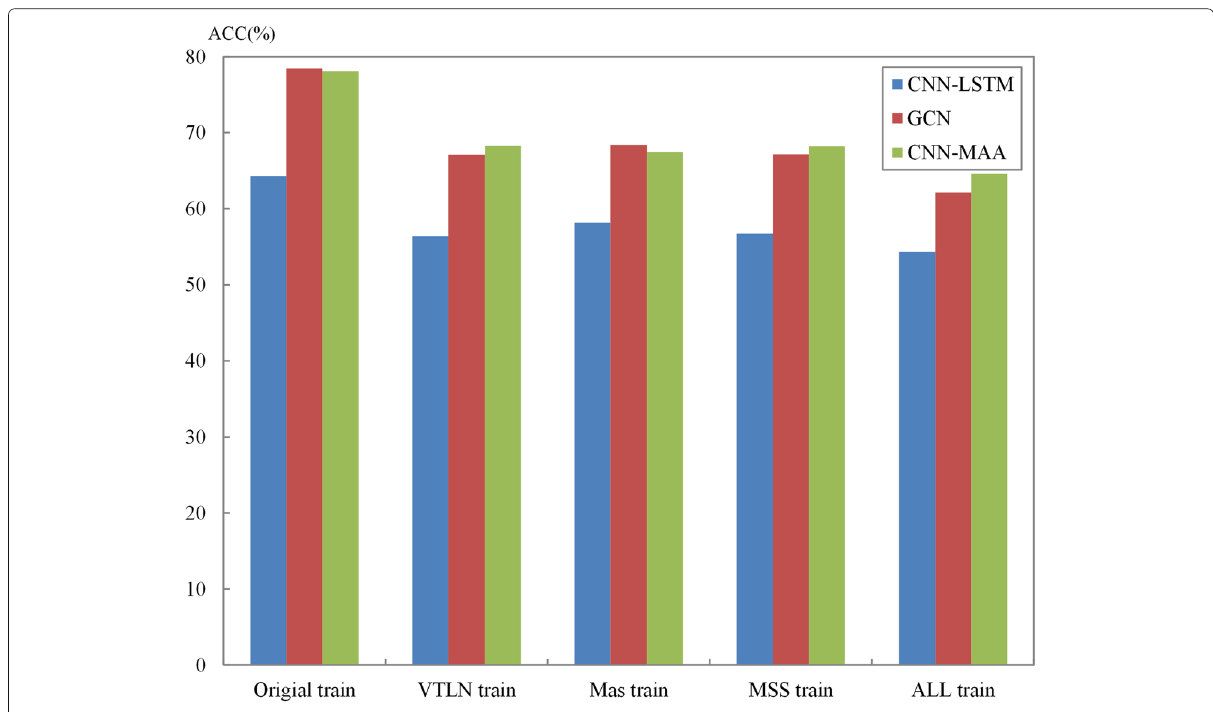
Fig. 9 Three models after adversarial